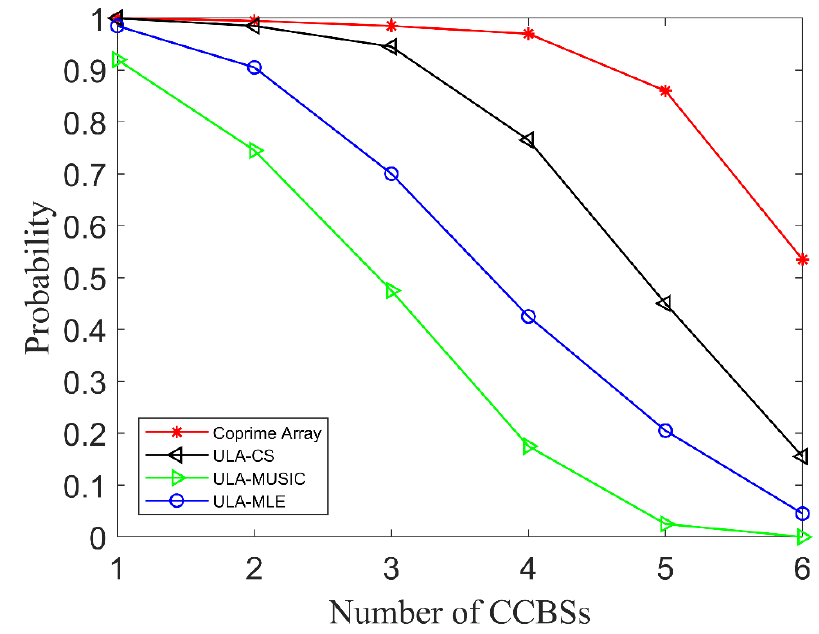
Figure 10. The relationship between the number of CCBSs and the probability of correct estimation.